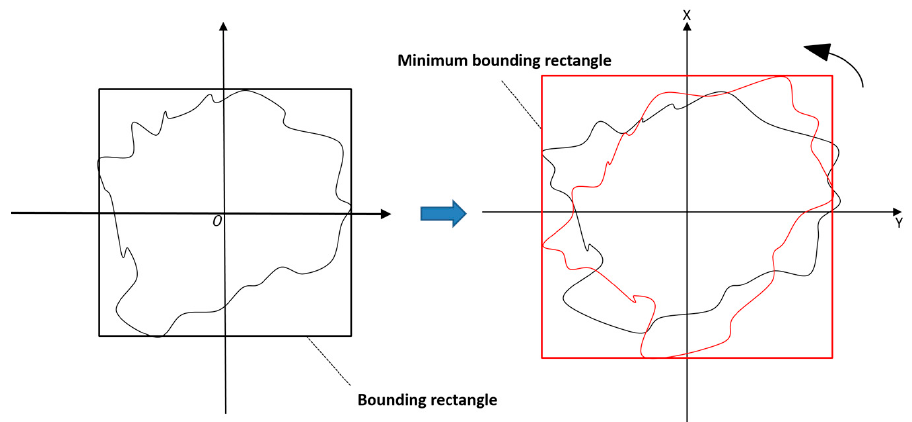
Figure 4. Application of the minimum bounding rectangle calculation.